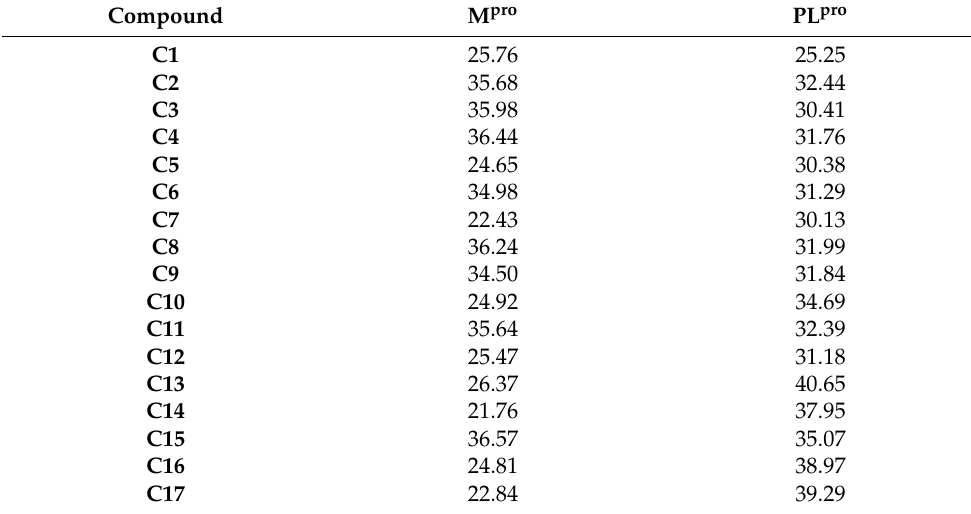
Table 1. The highest molecular docking score value (dimensionless) for the interaction between M pro /PL pro and each corrole under study ( C1 – C17